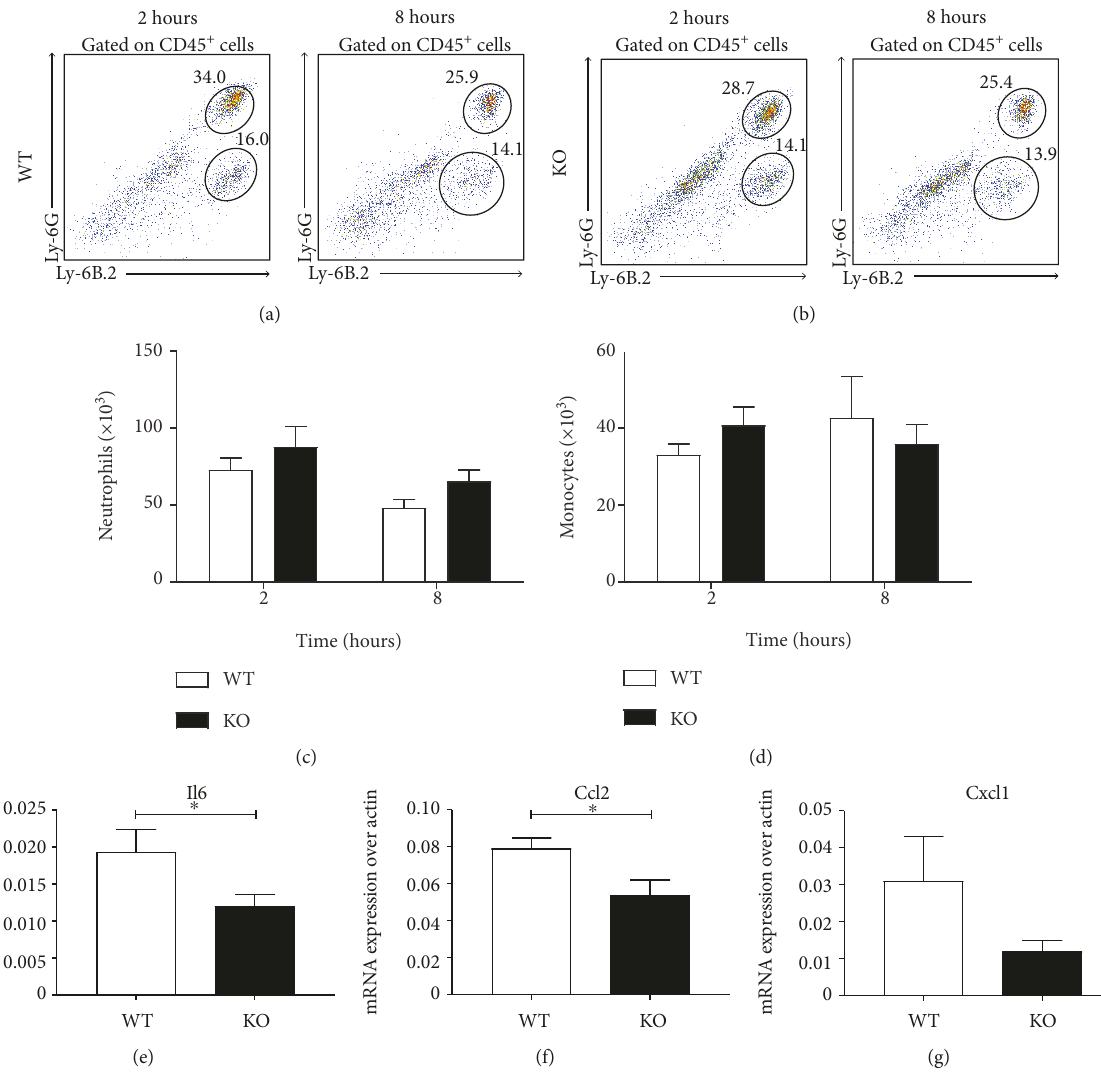
Figure 4: CB knockout mice have comparable numbers of neutrophils and monocytes in the lungs following LPS challenge. Male C57BL/6J 2 and CB knockout mice (8 – 10 weeks old) were administered i.p. with 1mg/kg LPS and innate immune cell recruitment to the lungs was 2 studied at 2 and 8 hours. Lung homogenates were stained for neutrophils (CD45 + Ly-6G hi Ly-6B.2 + ) and monocytes (CD45 + Ly-6G mid Ly-6B.2 + ) by fl ow cytometry. Representative dot plot graphs gated on CD45 + cells are shown from one C57BL/6J (a) and one CB for each time point. Pooled data from two independent experiments with 8-9 mice per group are shown for neutrophils (c) and for monocytes (d). (e – g) Proin fl ammatory mediator mRNA expression was measured in lung homogenates from wild-type and CB at 2 hours by qRT-PCR. Data for Il6 (e), Ccl2 (f), and Cxcl1 (g) are pooled from two independent experiments with 8-9 mice per group and 4-5 mice per group per experiment. Mean+SEM are represented in all bar graphs and data were analysed with a one-tailed student t -test (e – g) or a two-way ANOVA with Sidak ’ s post hoc multiple comparisons test (b, d), ∗ p < 0 05